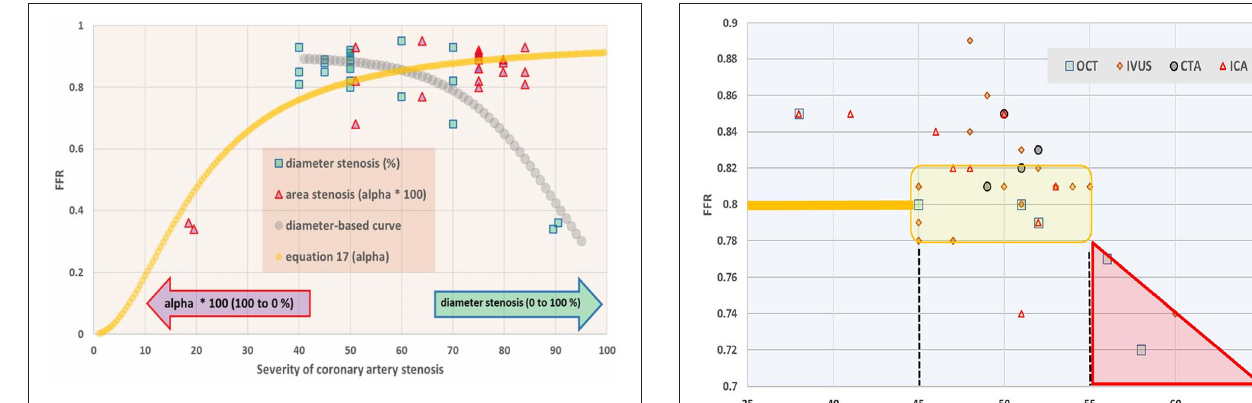
FIGURE 7 | Fractional flow reserve ( FFR ) in dependence of degree of coronary artery stenosis. For the patients studied ( N 22), the FFR is shown vs. = percentage diameter stenosis (squares) as well as vs. the metric α as defined FIGURE 9 | Survey of relationship between FFR and diameter stenosis. in Equation (8) (triangles). On the abscissa the scales for these metrics run in Average values reported in 38 studies on the basis of four measurement opposite directions, and therefore all data points are shown twice. Note that techniques: optical coherence tomography (OCT), intravascular ultrasound FFR sharply drops if the stenosis exceeds 70% diameter reduction. The curve (IVUS), computed tomography angiography (CTA), and intracoronary for α (Equation 17) shows a sigmoid pattern. In the section Discussion, this angiography (ICA). Most authors employ linear regression or fit a second order graph is compared with results from the in silico study ( Figure 3 , upper-left). polynomial for their study participants. The yellow shaded area refers to values of 0.78 FFR 0.82 around the common cut-off point, which narrow range ≤ ≤ corresponds with (averaged) diameter reduction anywhere between 45 and 55%. Data from Chu et al. (